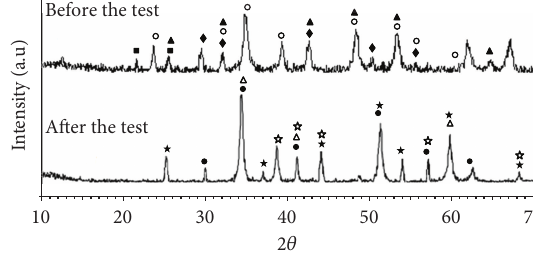
F 6: XRD patterns of the sulfur-treated catalysts